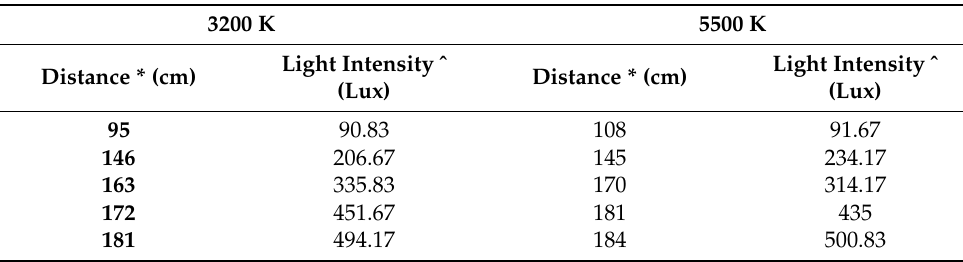
Table 1. Compare the relation among light intensity (Lux), light color (Kelvin), and detection distance (cm) for light source with a